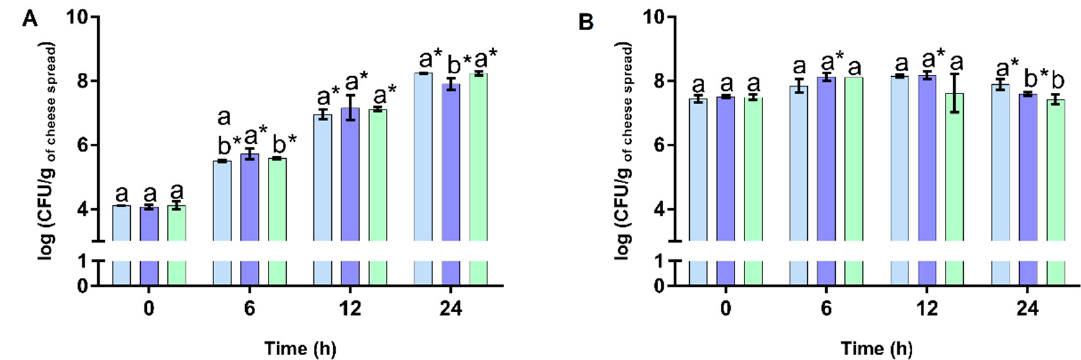
Figure 3. Evolution of viable cell numbers of Lactobacillus acidophilus LA-5 ® ( A ) and those of Bifidobacterium animalis subsp lactis BB-12 ® ( B ) in the cheese spread incorporated with Osmundea pinnatifida (CSExt, shown by the blue bar), the plain cheese spread (CS, shown by the purple bar), and the cheese spread with FOS (CSFos, shown by the green bar) after 21 days of refrigerated storage, incubated over 24 h at 37 °C. Different letters indicate statistically significant differences ( p < 0.05) between the three cheese spreads at each sampling time, while bars marked with * means statistically significant differences ( p < 0.05) in comparison to the data obtained at 0 h.